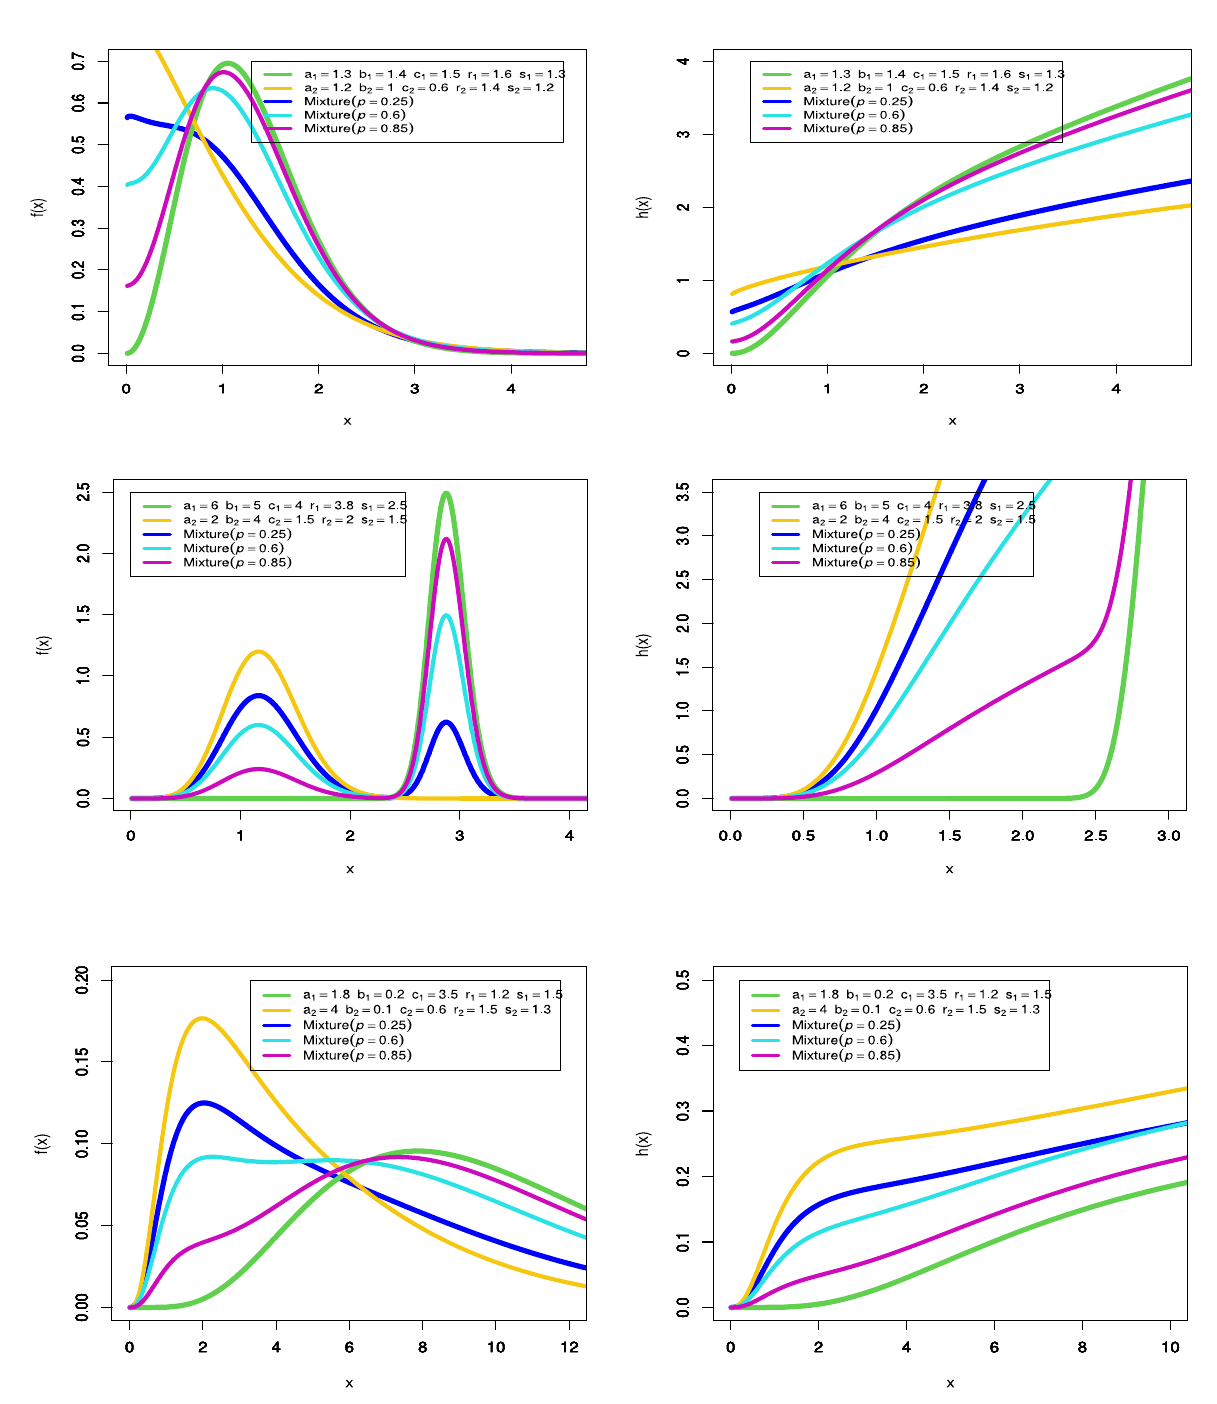
Figure 1. The pdf and hrf of the MEKW model for different values of its parameters.